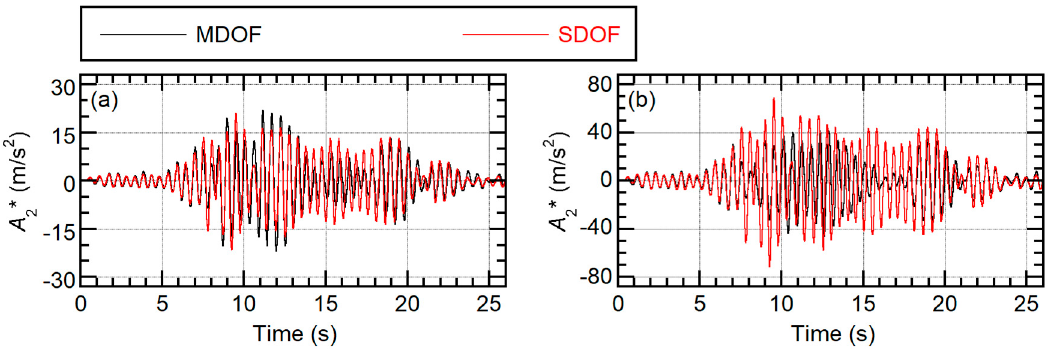
Figure 20. Time-history comparison of second modal acceleration: ( a ) Art-S06, 50%; ( b ) Art-S06, 100%.